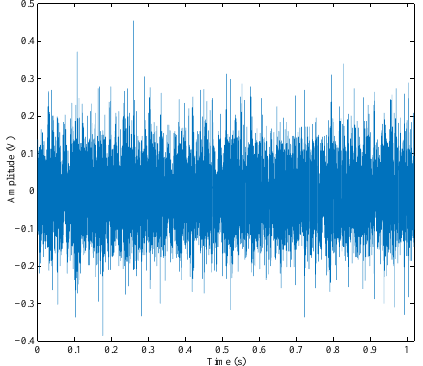
Figure 4. The original signals of the first data